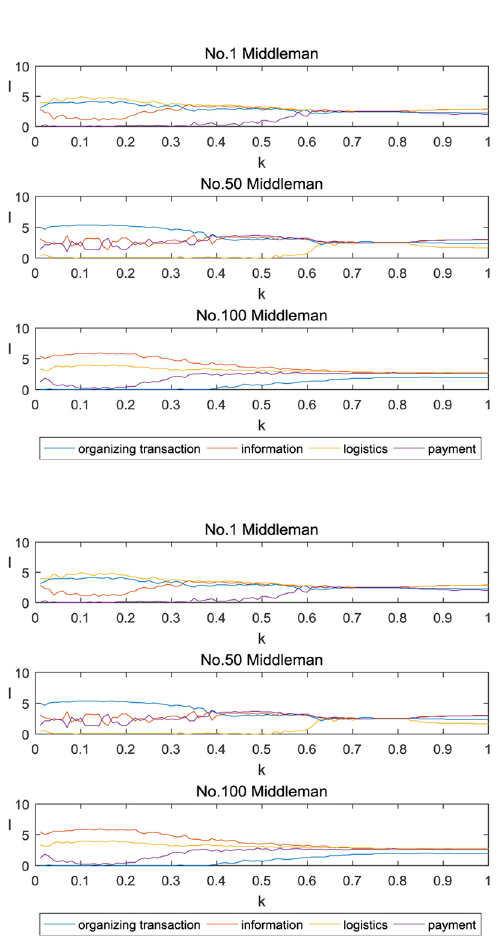
Figure 7. Price gradient h =